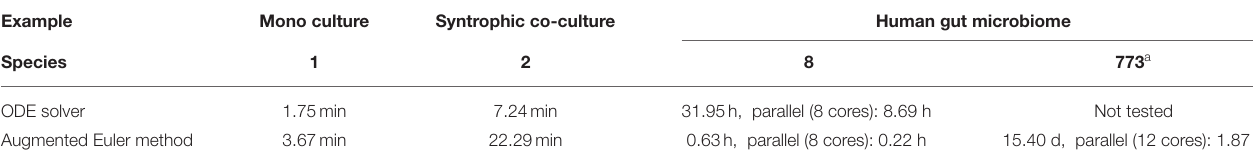
TABLE 3 | Simulation